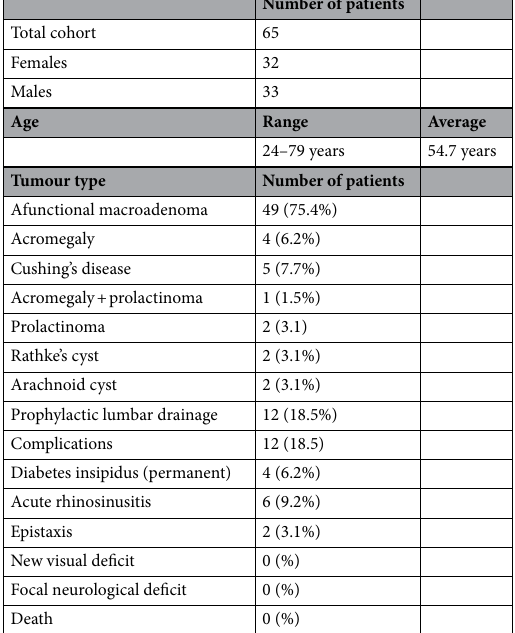
Table 1. Characteristics of the cohort—gender, age, tumour type, prophylactic lumbar drainage,